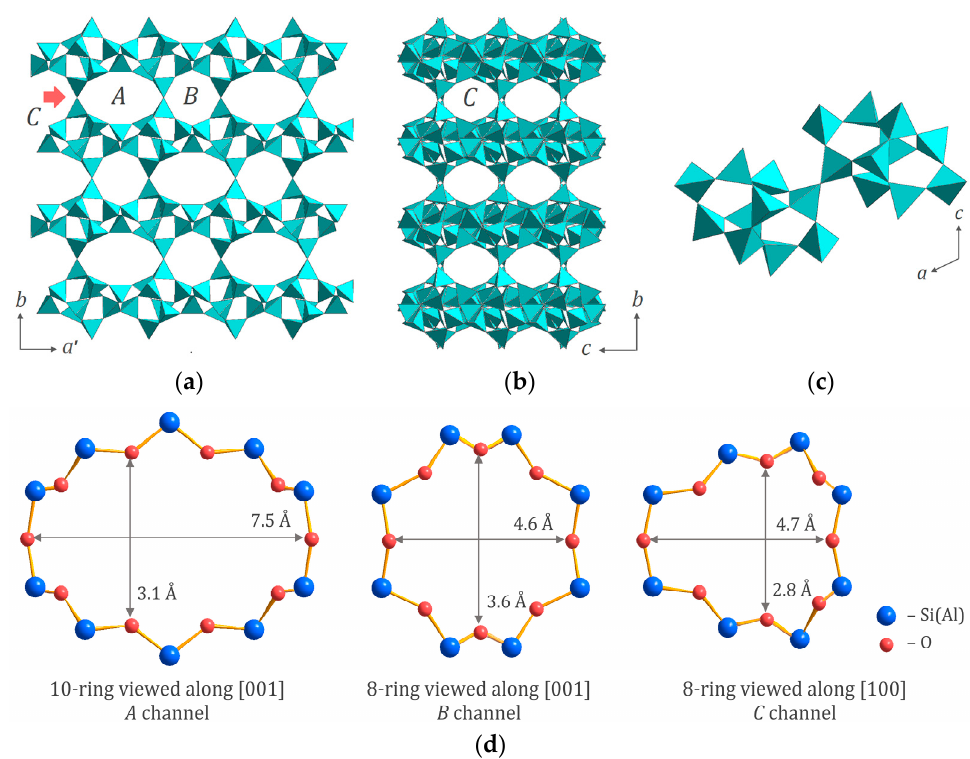
Figure 3. Schematic representation of different sections of HEU zeolite framework type viewed along [001] ( a ’ = a sin β ) ( a ), [100] ( b ) and [010] ( c ) directions; A , B , C channels ( a , b ) and two corner-sharing T 10 O 20 units ( c ) as well as 10- and 8-membered rings ( d ) of the HEU structure are shown.